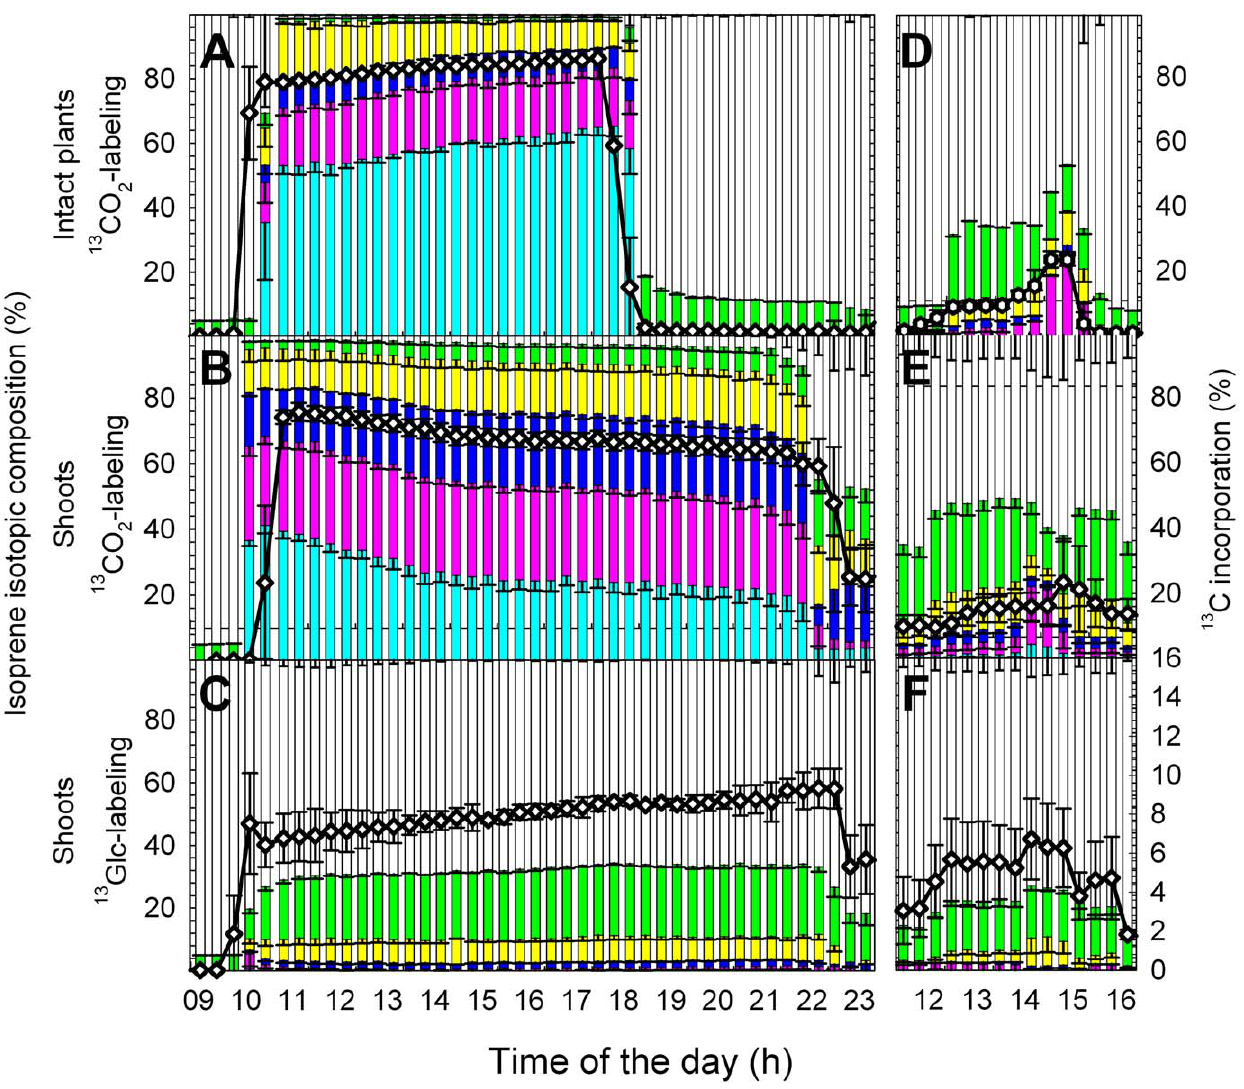
Figure 8. Isotopic composition of isoprene molecules and the corresponding 13 C-incorporation during 13 C-labeling of intact poplar plants and detached shoots. Pattern of isoprene isotopologues (m74, light blue; m73, magenta; m72, dark blue; m71, yellow; m70, green; m69, white) and 13 C-incorporation (open circles) in (A) intact plants, (B) shoots labeled with 13 CO 2 , and (C) shoots labeled with 13 Glc. Panels (D), (E), and (F) show the isotopic composition of isoprene emitted by the same plants during the period with CO 2 -free air. Details of the experimental phases can be found in the Materials and Methods section. Data represent the mean of 3 experiments 6 s.e.